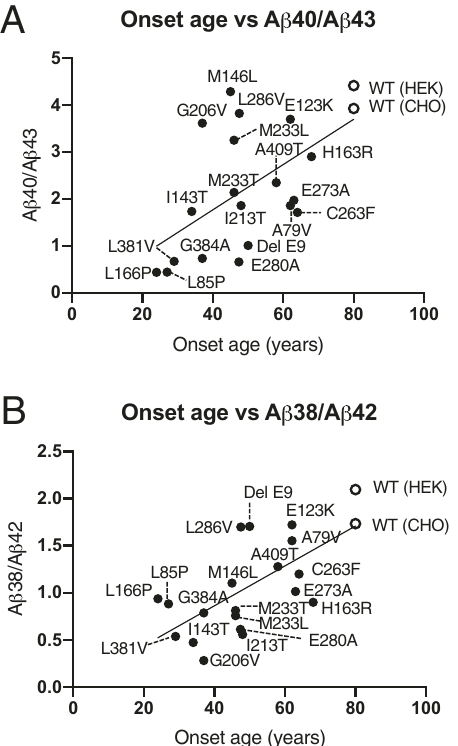
Fig. 3 Onset age versus the ratio of A β for each FAD mutation by γ -secretase assay in vitro. A , B The ratio of A β 40/A β 43 or A β 38/A β 42 versus onset age is on the regression line. These plots suggest onset age dependency. The open circles indicate WT PS1, and the closed circles indicate FAD mutant PS1. ( n =